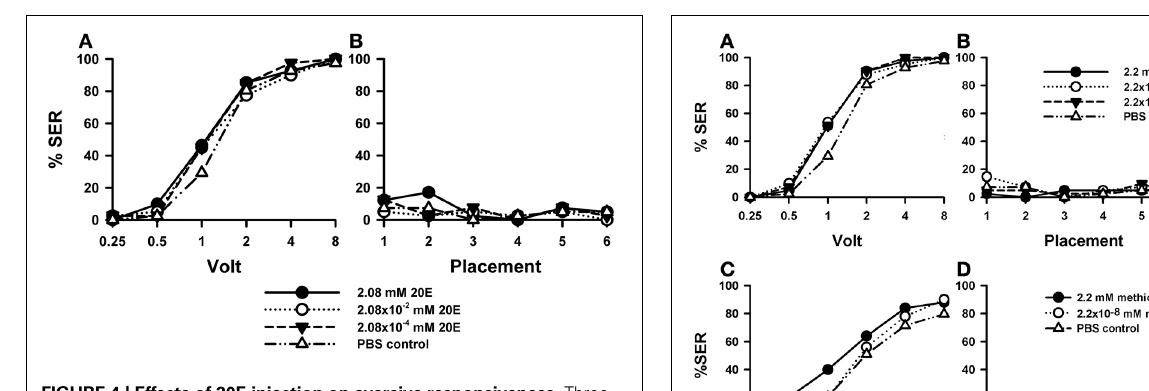
FIGURE 4 | Effects of 20E injection on aversive responsiveness. Three different groups of bees were injected with three different concentrations of 20E (2.08mM: n = 41; 2.08 × 10 − 2 mM: n = 40; 2.08 × 10 − 4 mM: n = 40). A fourth group was injected with PBS as a control ( n = 41). Sting responsiveness was measured in response to increasing voltages during shock trials (A) and during placement trials (B) . All three 20E concentrations induced the same responsiveness as the PBS control in the